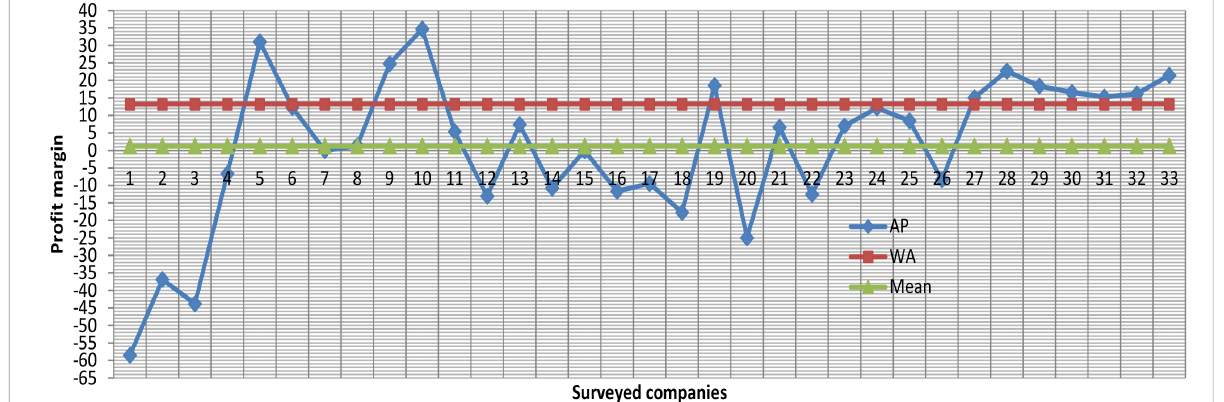
Figure1. Line chart to show gap between actual performance and world average in profit margin